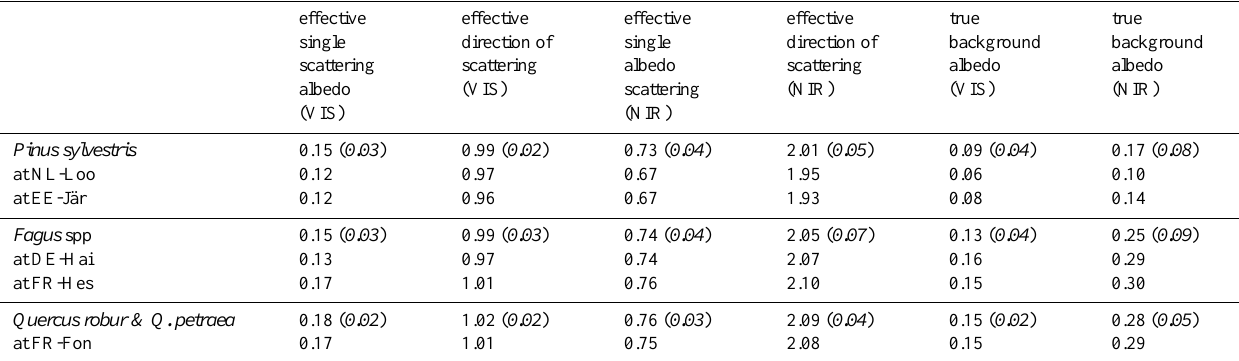
Table 2. Observed mean radiative properties for the tree species used in this study for June: effective single scattering albedo, effective preferred direction of scattering and true background albedo were extracted from the JRC-TIP product. One standard deviation is given in brackets. In addition, the same variables are given for each site used for the validation of the model chain. Legend for single sites: Loobos in the Netherlands (coded NL-Loo, 52.17 ◦ N, 5.74 ◦ E), Järvselja in Estonia (coded EE-Jär, 58.31 ◦ N, 27.30 ◦ E), Hainich in Germany (coded DE-Hai, 51.08 ◦ N, 10.45 ◦ E), Hesse in France (coded FR-Hes, 48.67 ◦ N, 7.07 ◦ E), Fontainebleau in France (coded FR-Fon, 48.48 ◦ N, E2.78 ◦